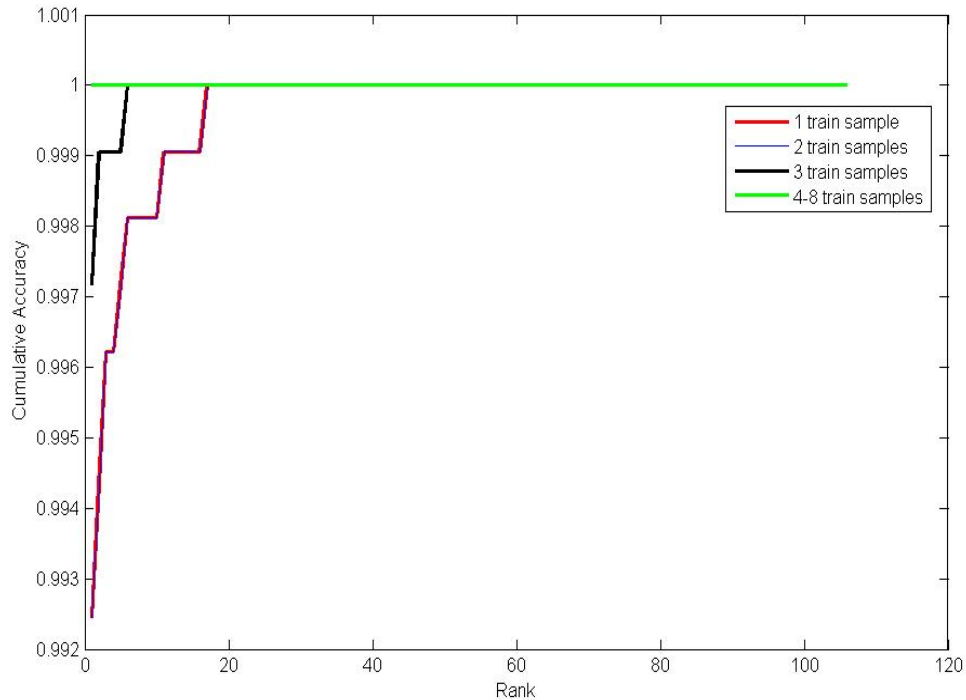
Figure 12. Cumulative match curves by different number of training